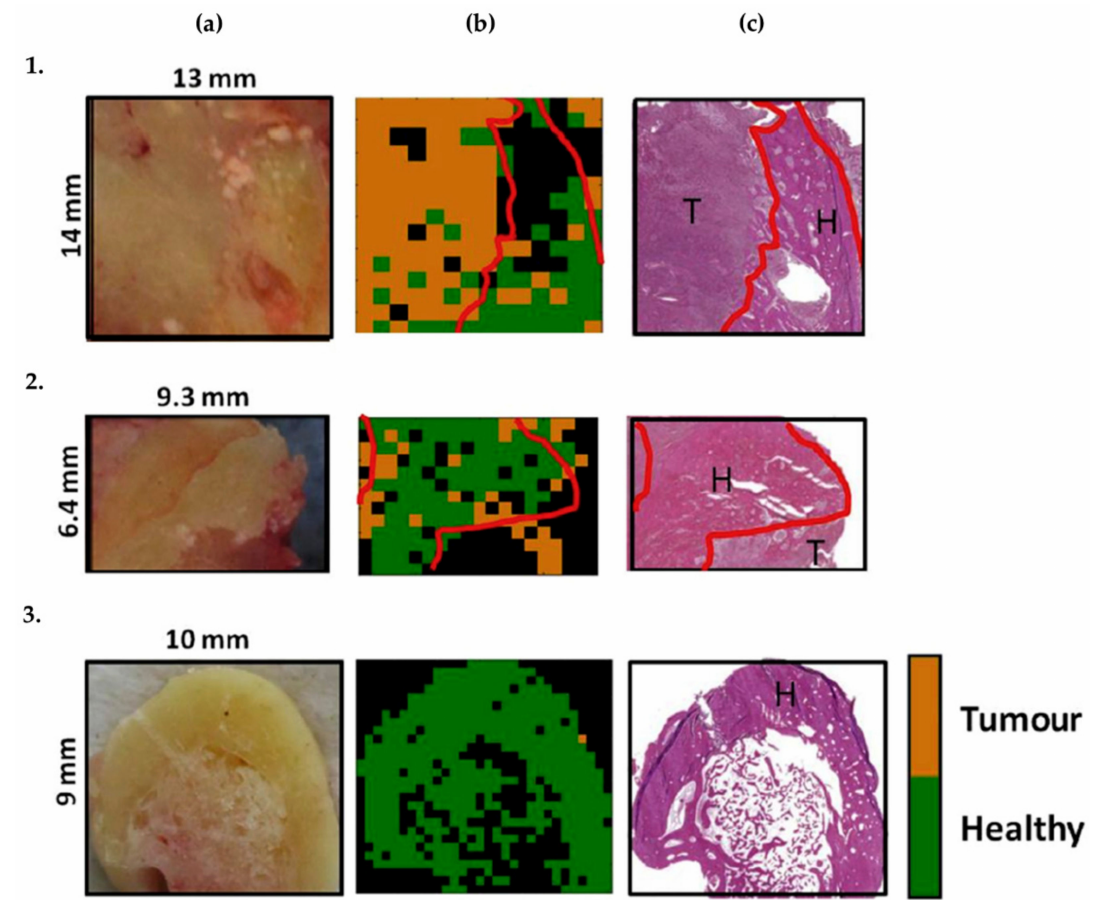
Figure 7. Examples of the results obtained when testing the tissue classification model developed by Barroso et al. ( a ) Photographs of fresh bone cross sections from the centre of a resection specimen with tumour invasion (based on radiologic examination) from which Raman spectra were obtained. ( b ) Raman classification maps (orange: tumour, green: healthy bone) tumour border indicated in red. Black pixels correspond to the absence of tissue or to spectra with low Raman signal quality. ( c ) H&E-stained sections obtained from the measured bone surface, with tumour border (red), tumour (T) and healthy surrounding bone (H) indicated by the pathologist, obtained from 3 bone slices from 3 patients (1 to 3)